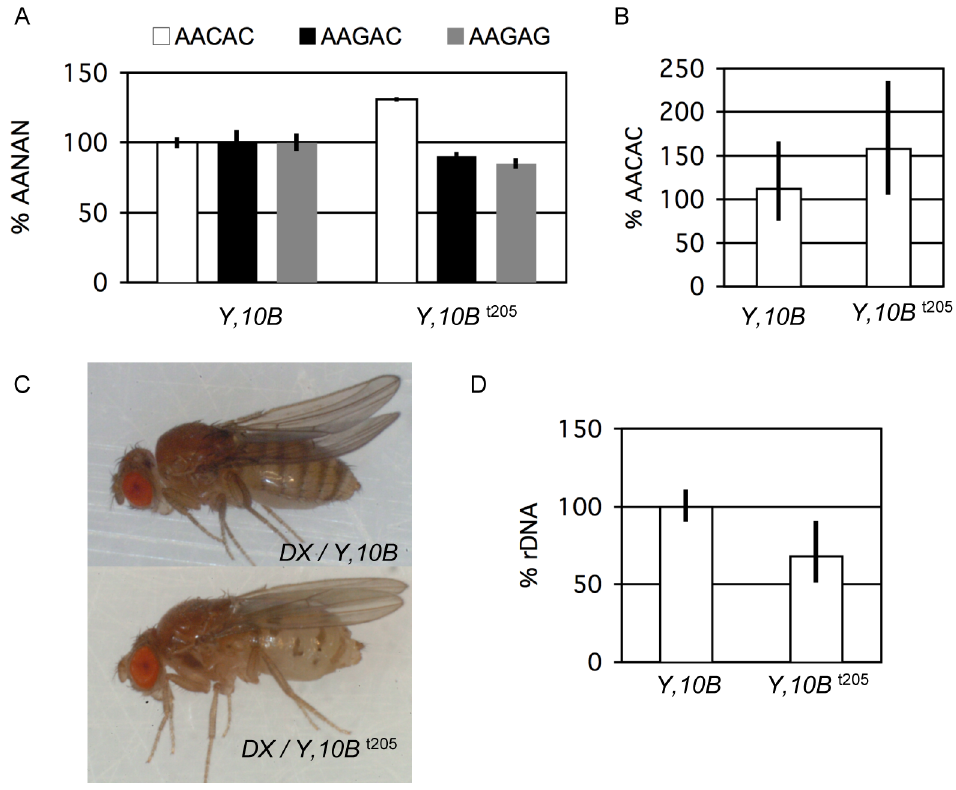
Figure 4. Quantification of satellite copy number variation after a exposure to Su ( var ) 205 05 / + mutation. ( A ) Relative satellite copy number on Y , 10B t205 compared to Y , 10B (defined as 100%). The chromosomes are originally from a single progenitor, but the former was maintained for 6 years in a Su ( var ) 205 5 / CyO mutant background. Error bars represent standard error of the mean (S.E.M.) of quadruplicate qPCR reactions. ( B ) DNA from four individual males bearing Y , 10B t205 were separately prepared and used as template for qPCR. Graphs show population average, error bars represent standard deviation (S.D.) of individuals within populations pooled with standard error of the mean (S.E.M.) of replicate reactions. Average AACAC copy number (in (A)) are comparable to the average of the population (in (B)), and population distributions remain detectably different (10B vs . 10B t205 in (B), P=0.0336). ( C ) Images of female flies of genotype C ( 1 ) DX / Y , 10B (top) and C ( 1 ) DX / Y , 10B t205 (bottom). The fly with 10B t205 as sole source of rDNA exhibits a strong bobbed phenotype, indicating significant rDNA loss. ( D ) qPCR determination of rDNA copy number in the flies from (C). Error bars report standard error of the mean of replicate qPCR reactions from pooled siblings.